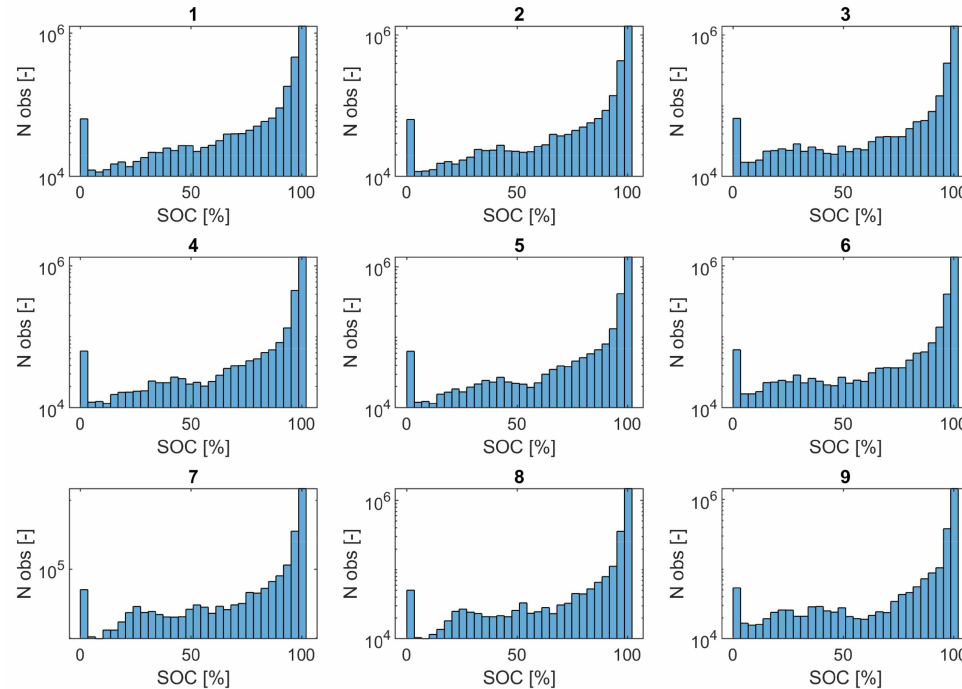
Figure 13. The SOC distribution (cases 1–9).